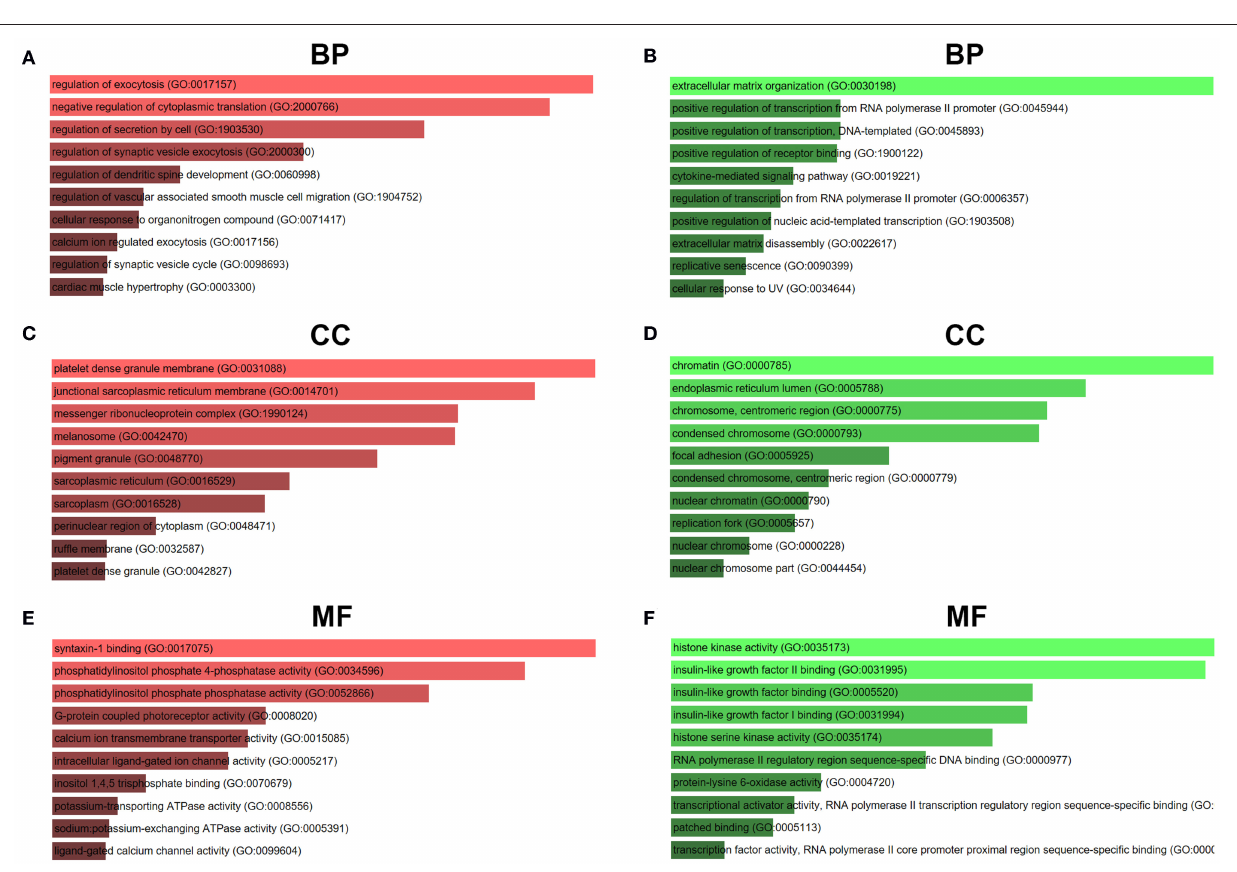
software. The top 10 hub genes were listed in Table 3 . For the target genes of upregulated DE-miRNAs, the hub genes were STXBP1, MYO5A, NSF, ITPR1, PPP3CB, PRKCE, RAB40B, TPPP, TRPC5, and RYR2. For the target genes of downregulated DE-miRNAs, the hub genes were TP53,